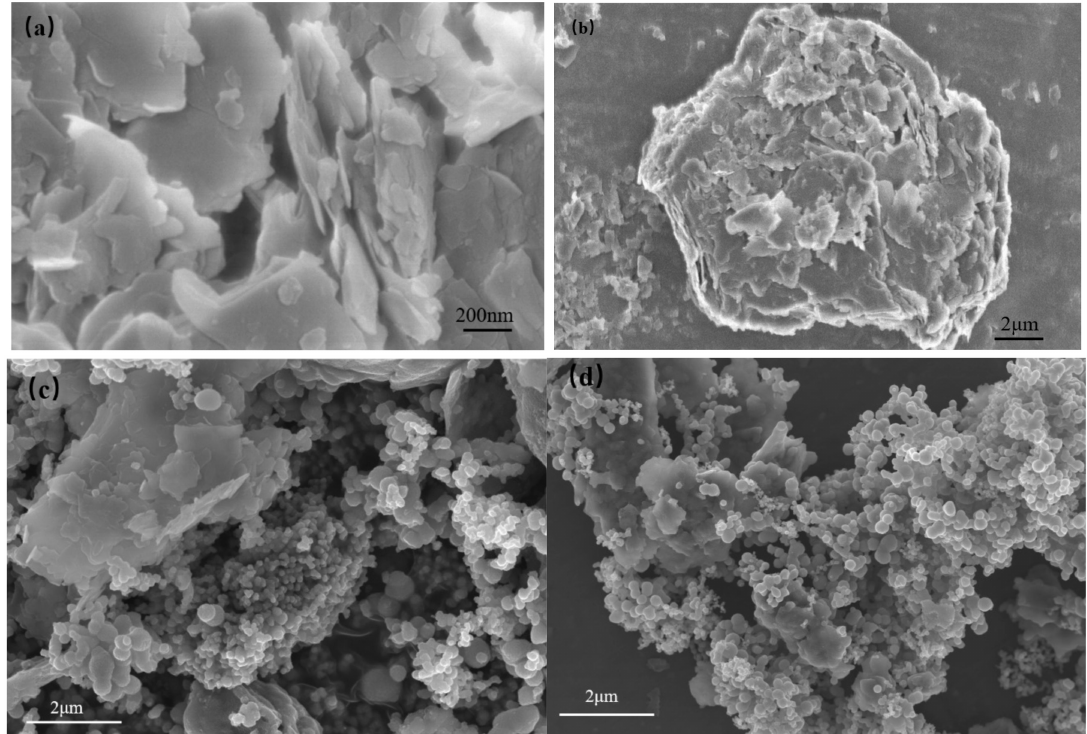
Figure 2. ( a , b ) SEM images of black talc; ( c , d ) SEM images of the photocatalyst.